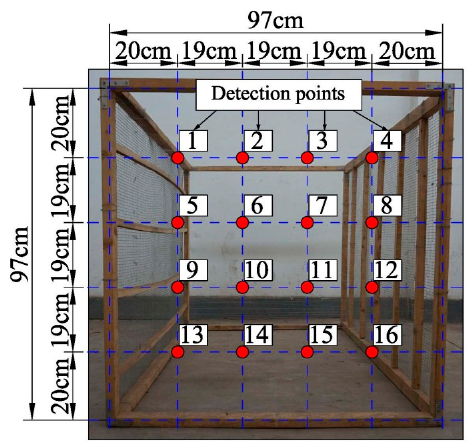
Figure 4. Distribution diagram of detection points.